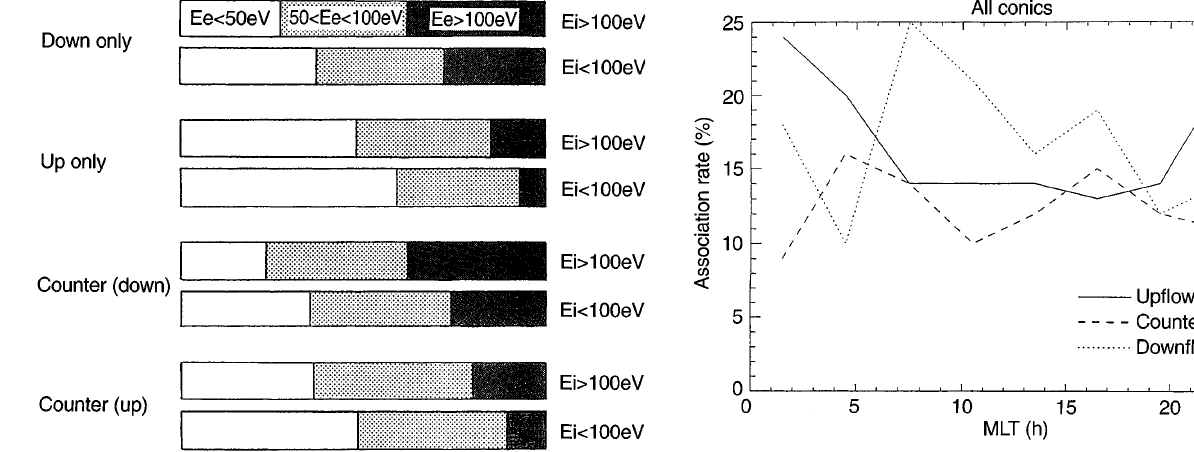
Fig. 6. MLT dependence of the association rate of electron beams with ion conics. The three curves in the figure correspond to the three types of the electron beam